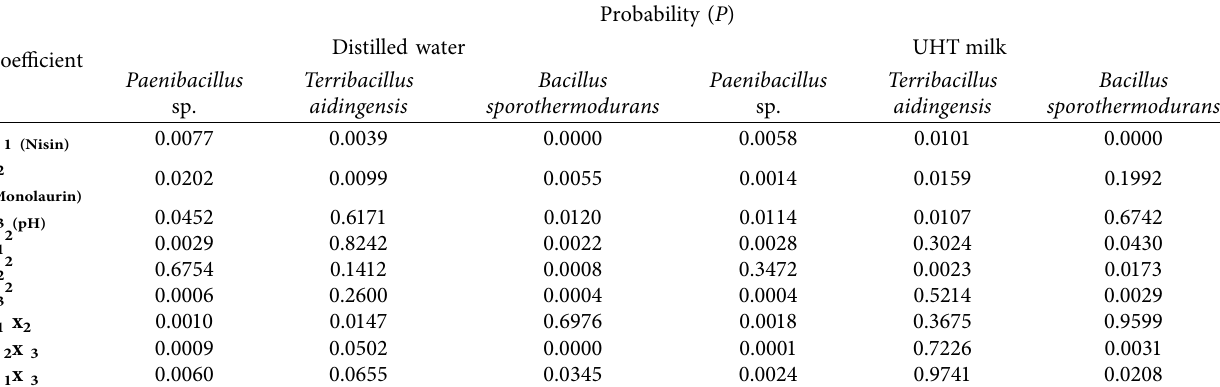
Table 3: Statistical significance test of the coefficients of different equations obtained in the inactivation of Bacillus spores by nisin, monolaurin, and